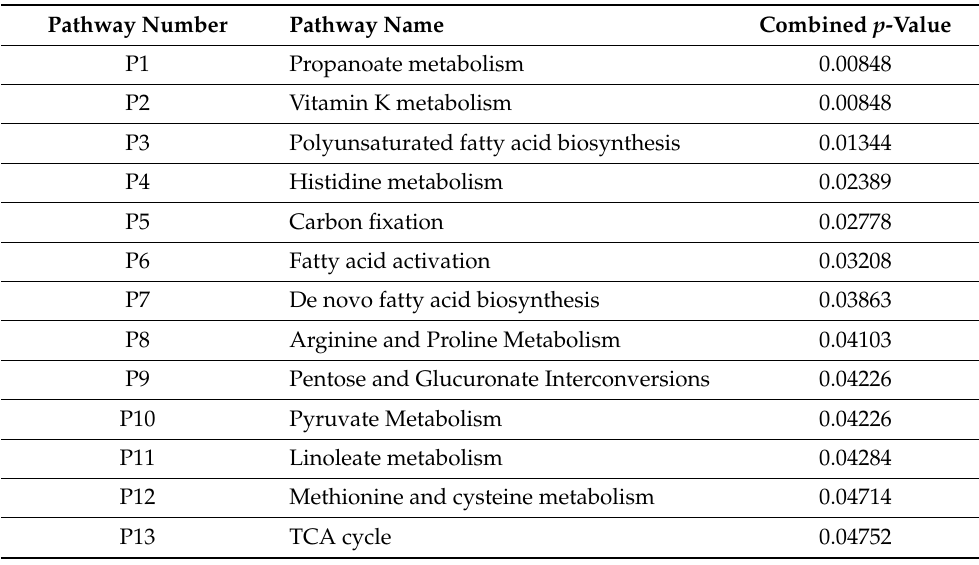
Table 5. Significantly perturbed metabolic pathways that differentiated malignant and oral tissues.